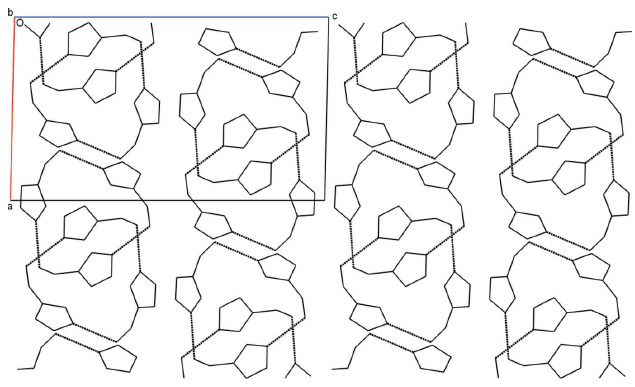
Figure 4 The packing arrangement of the three-molecule supermolecule with hydrogen bonds represented as dashed lines as viewed along the b axis of the unit cell. The offset stacking of the three-membered supermolecule is due to the twofold screw axis orthogonal to this